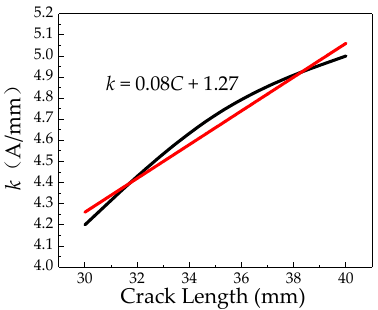
Figure 19. Relationship between the internal pressure increasing factor k and the crack length.